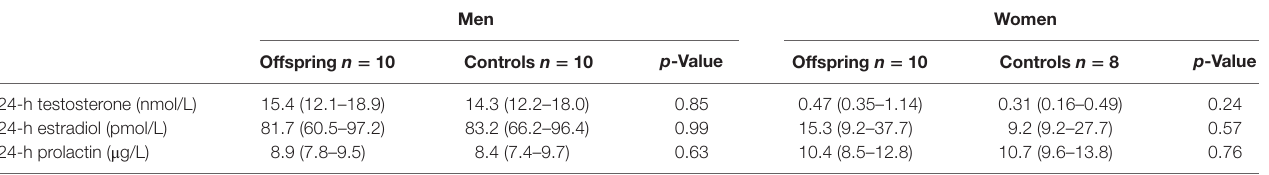
TaBle 4 | Testosterone, estradiol, and prolactin in a 24-h pool for offspring of long-lived families and